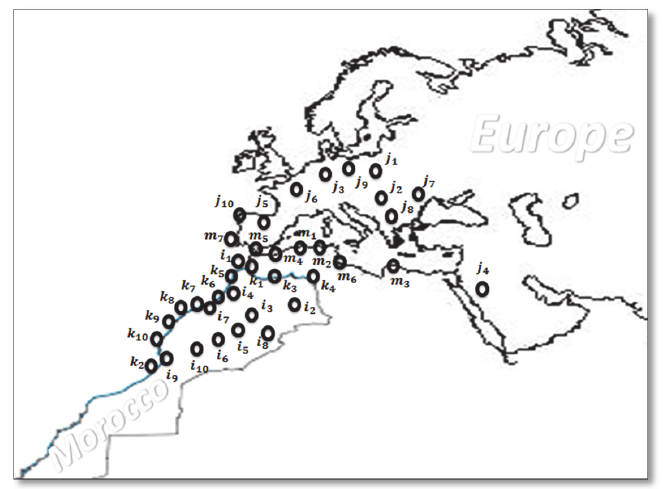
Fig. 6. Nodes of a real intermodal transport